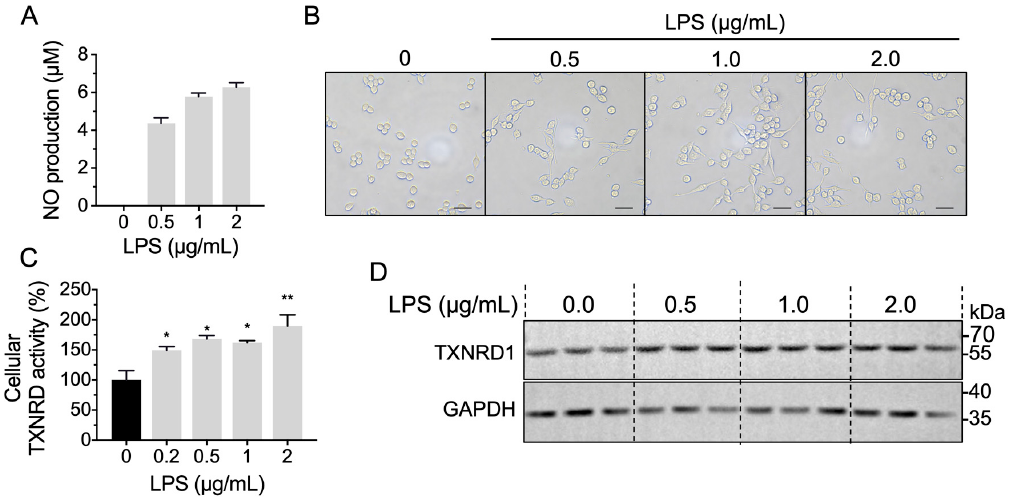
Figure 5. LPS-stimulation increases cellular TXNRD activity. ( A ) NO production of LPS-simulated RAW 264.7 cells. RAW 264.7 cells were treated with LPS for 24 h and the NO production was assayed. ( B ) Cellular morphology image of RAW 264.7 cells upon LPS treatment for 6 h. Scale bar represents 200 μ m. ( C , D ) Cellular TXNRD activity and TXNRD1 protein level were determined upon LPS treatment for 6 h in RAW 264.7 cells. *, p < 0.05, **, p < 0.01.